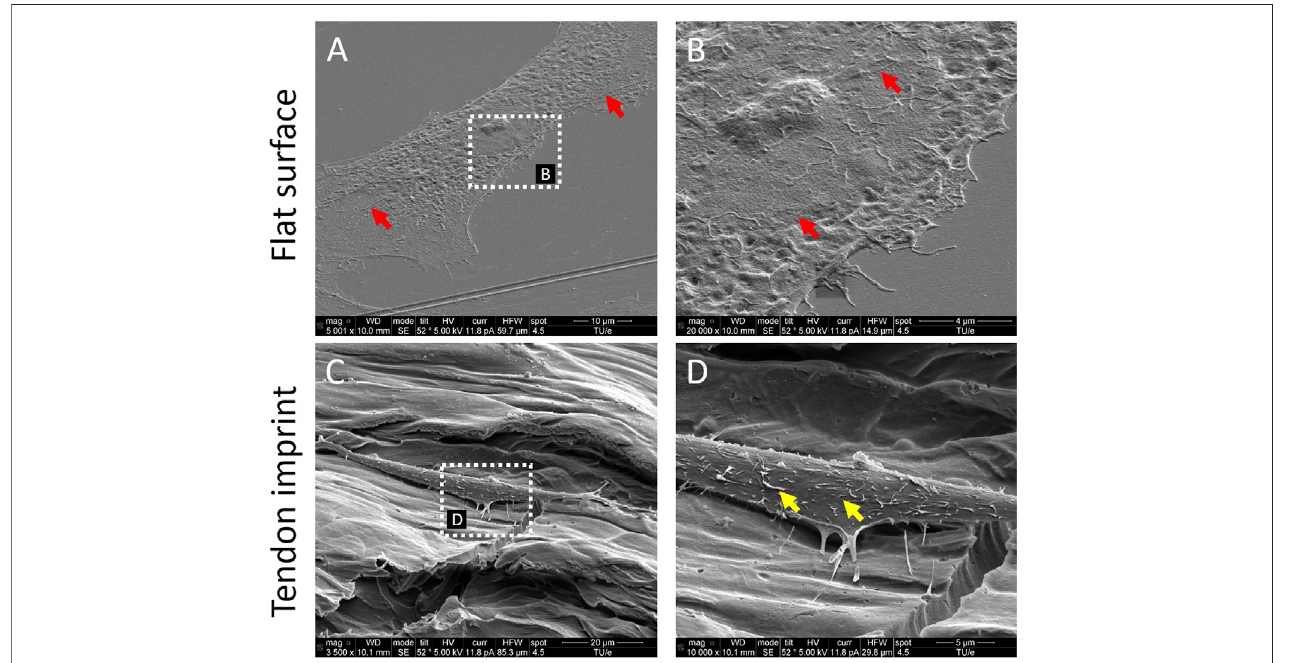
FIGURE 1 | Tendon imprints induce cell shape changes. (A) Tenocyte on a fl at surface. (B) Higher magni fi cation image of tenocytes on the fl at surface that illustrates cell adhesion points in higher resolution. Red arrows indicate stress fi bers and yellow arrows indicate membrane invaginations sticking from the plasma membrane. (C) Tenocyte on the tendon imprint. (D) Higher magni fi cation image of tenocytes on tendon imprint. Filopodia are observed on both